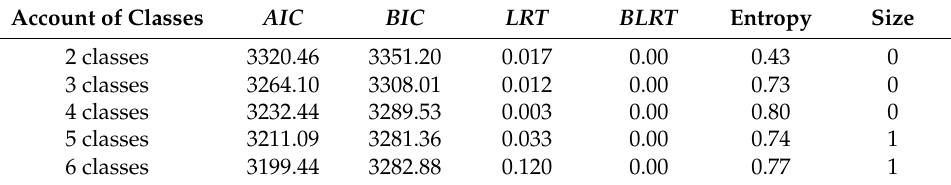
Table 2. Fit indexes of the results of the Latent Profile Analysis (LPA).